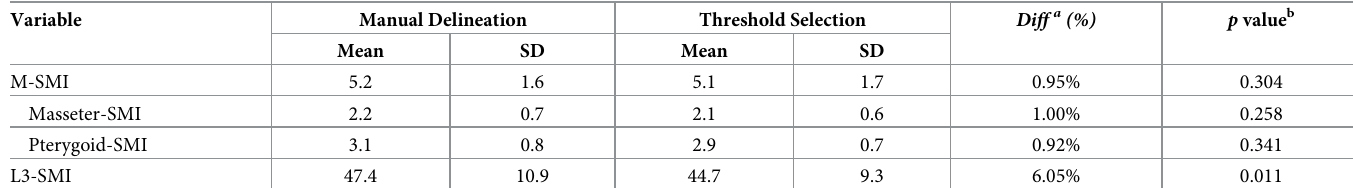
Table 2. Comparison between skeletal muscle index determined by manual delineation and threshold selection on L3 and masticatory muscle. Variable Manual Delineation